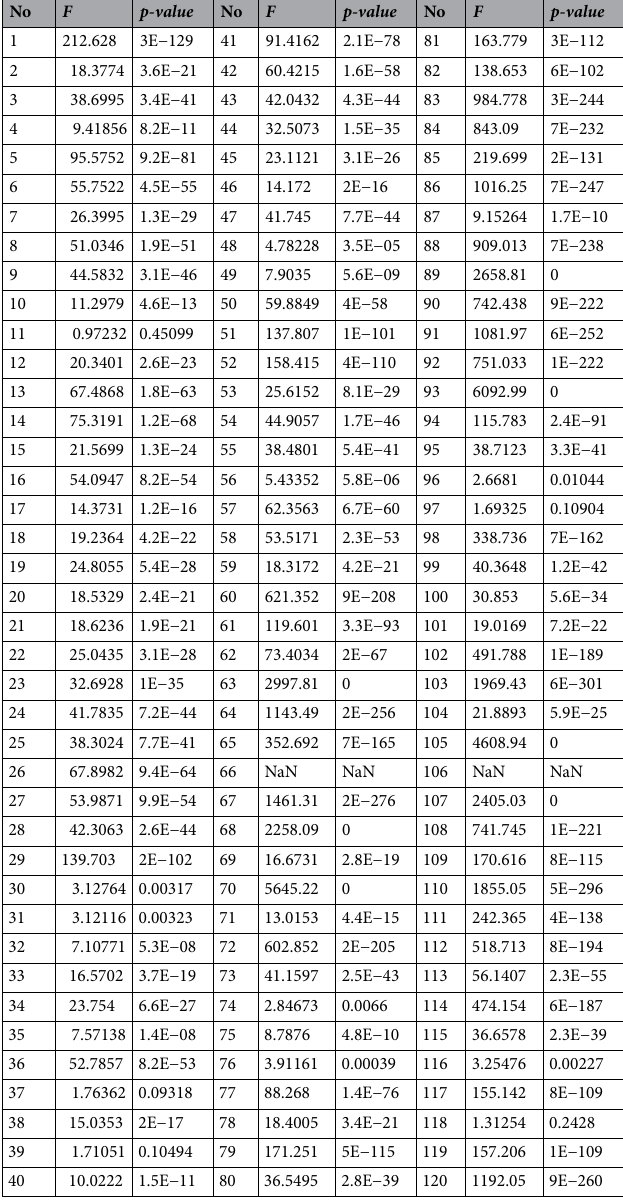
Table 11. Results of the ANOVA test. *NaN means there is no difference between